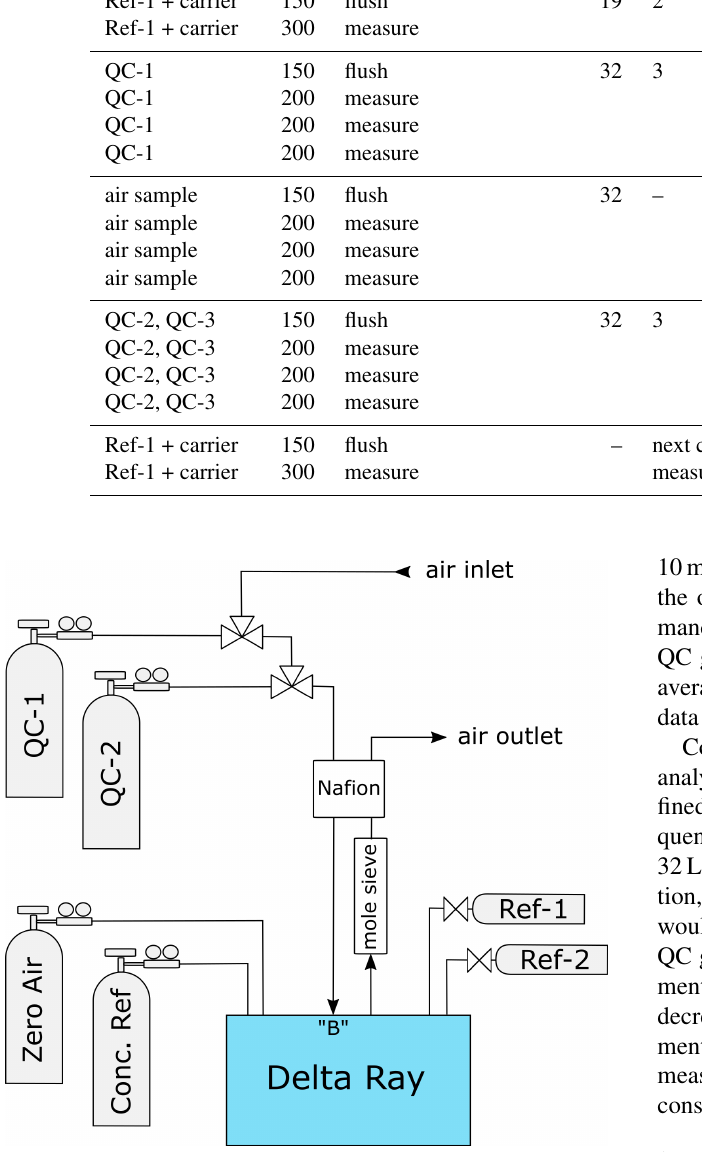
Figure 1. Delta Ray setup as deployed at